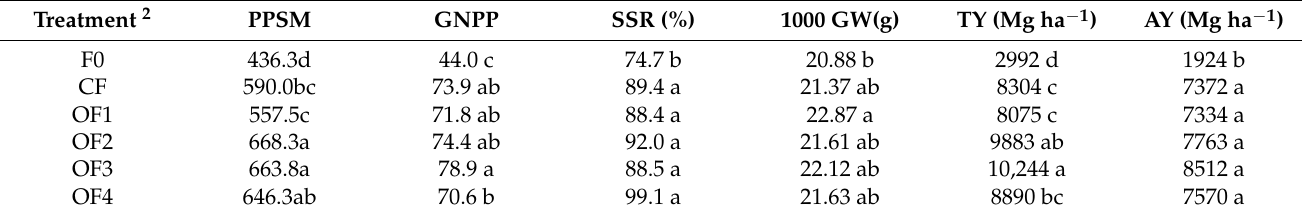
Table 3. Yield and yield components of dry direct-seeded rice 1 .